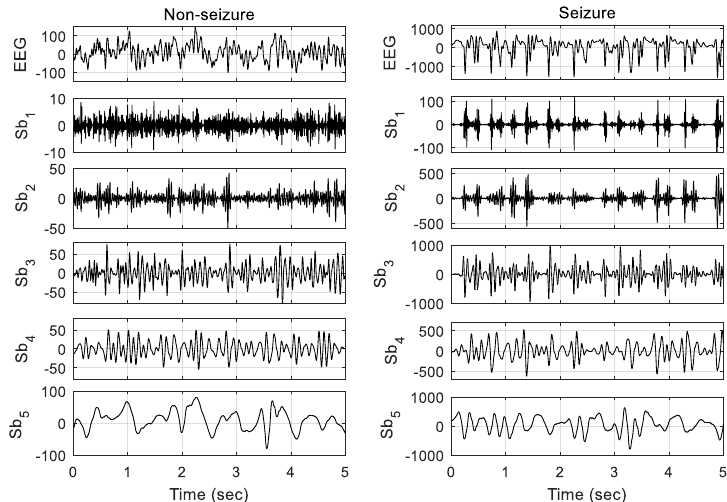
Figure 3. The EEG signals and their different subbands obtained by applying four levels of DWT. Left column: nonseizure EEG signal (from set A) and its five subbands; right column: seizure EEG signal (from set E) and its five subbands. Note that the signals of 5 s length (out of 10 s frames) are plotted here for better illustration.